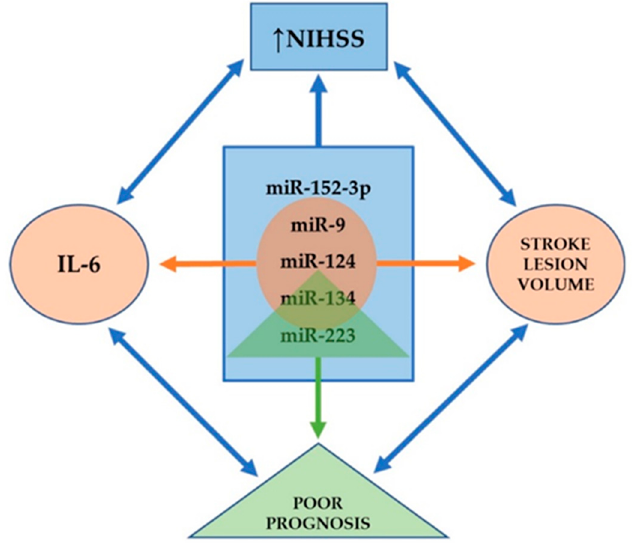
Figure 1. Exosomes as possible biomarkers in human studies. All the miRs listed in the central blue rectangle correlate to the NIHSS score. The three miRs listed in the orange circle correlate to infarct volume and serum concentrations of IL-6. The miRs in the green triangle are associated with poor prognosis. Nevertheless, all the elements representing clinical and paraclinical findings found around the blue rectangle correlate with each other.